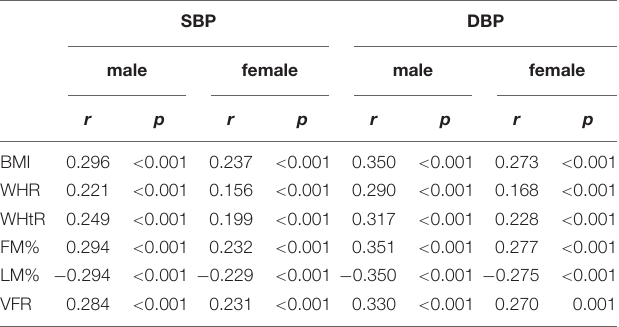
TABLE 2 | Partial Pearson Correlation between blood pressure and body composition indices in the subjects. SBP